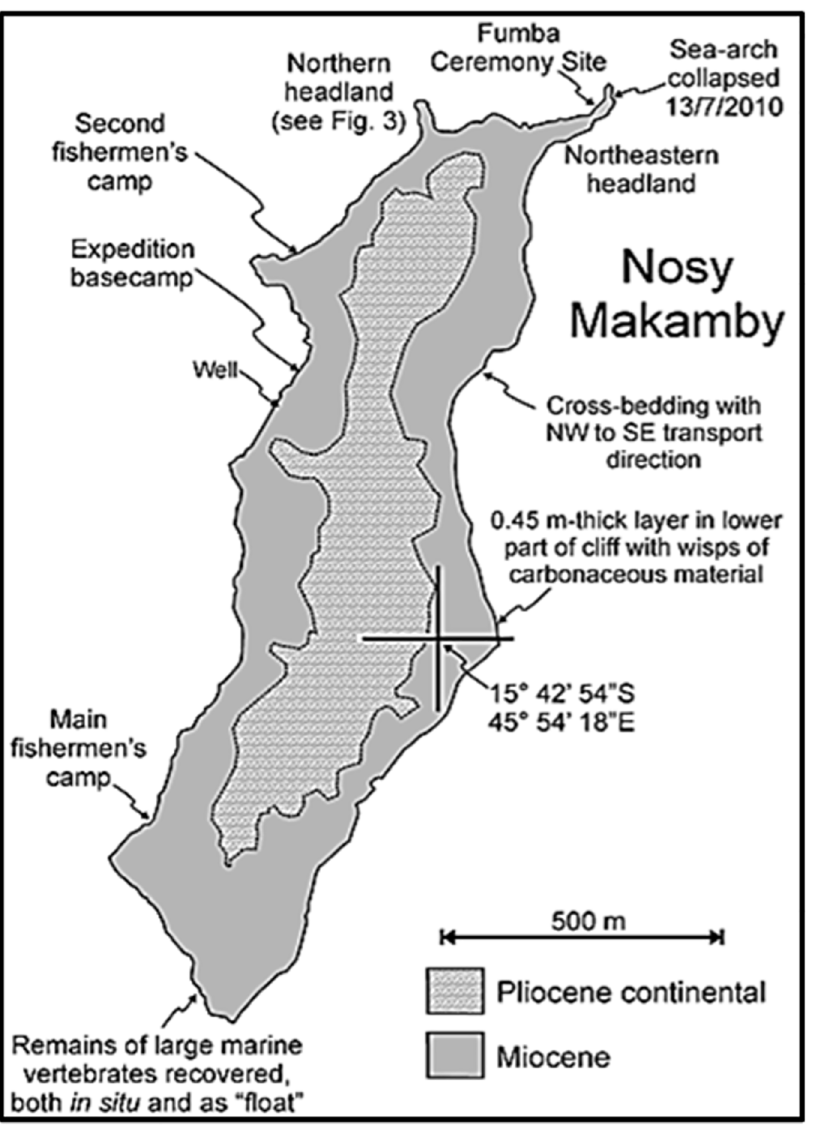
Fig 2. Nosy Makamby, showing location of principal Miocene fossil sites and geologic